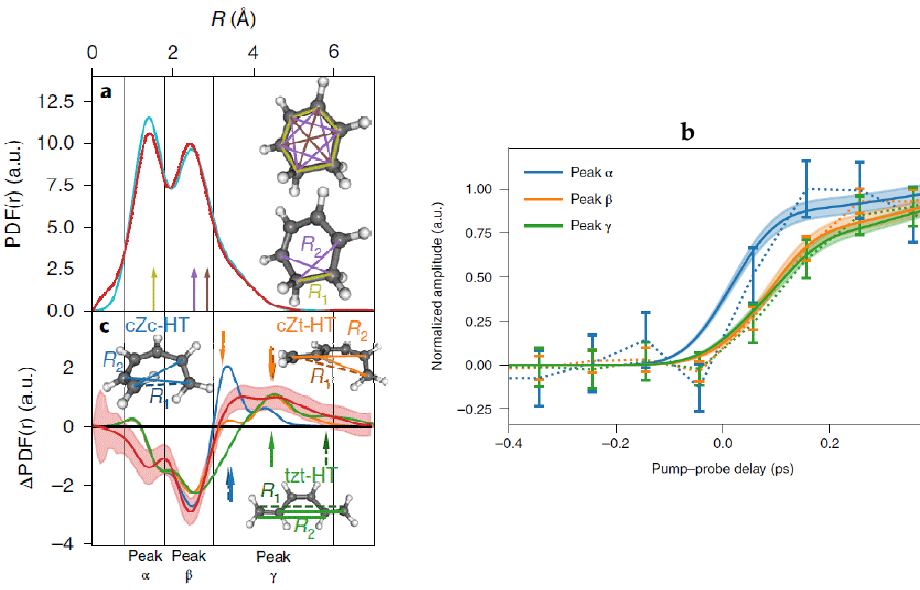
Figure 19. Left panels: (top; a ) comparison between simulated (light blue) and experimental (red) PDFs. Distances from α and β peaks are marked as yellow and purple lines. (bottom; c ) Simulated differential PDFs for three isomers occurring along the course of the reaction path. Right panel ( b ): comparison between experimental (dotted lines) and simulated (solid lines) delay in rise time between α, β and γ peaks. Figures reproduced with permission from Wolf et al. [156]. Copyright (2019) Springer Nature; access provided by the arViv public repository under the entry No. 1810.02900v1.